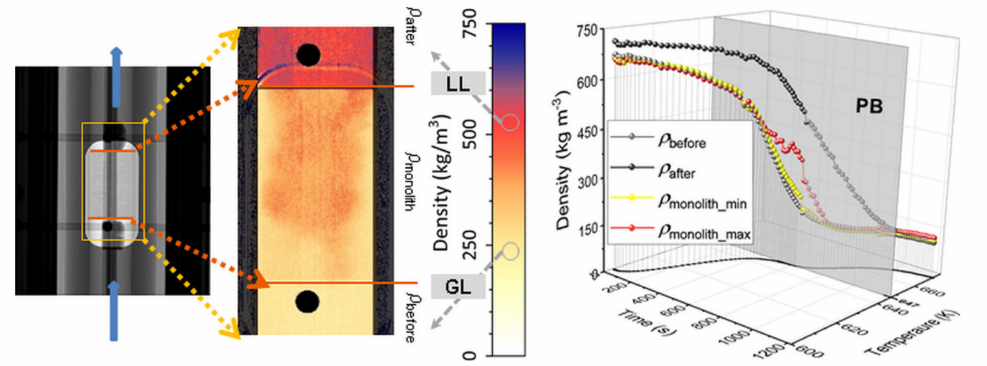
Figure 2. Water density fluctuations in the presence of carbon porous monolith; from left to right: the carbon monolith inside the SCW reactor, the color scaled water density map and the density variation over time; it is visible the LL/GL phase separation at the time of PB (adapted from